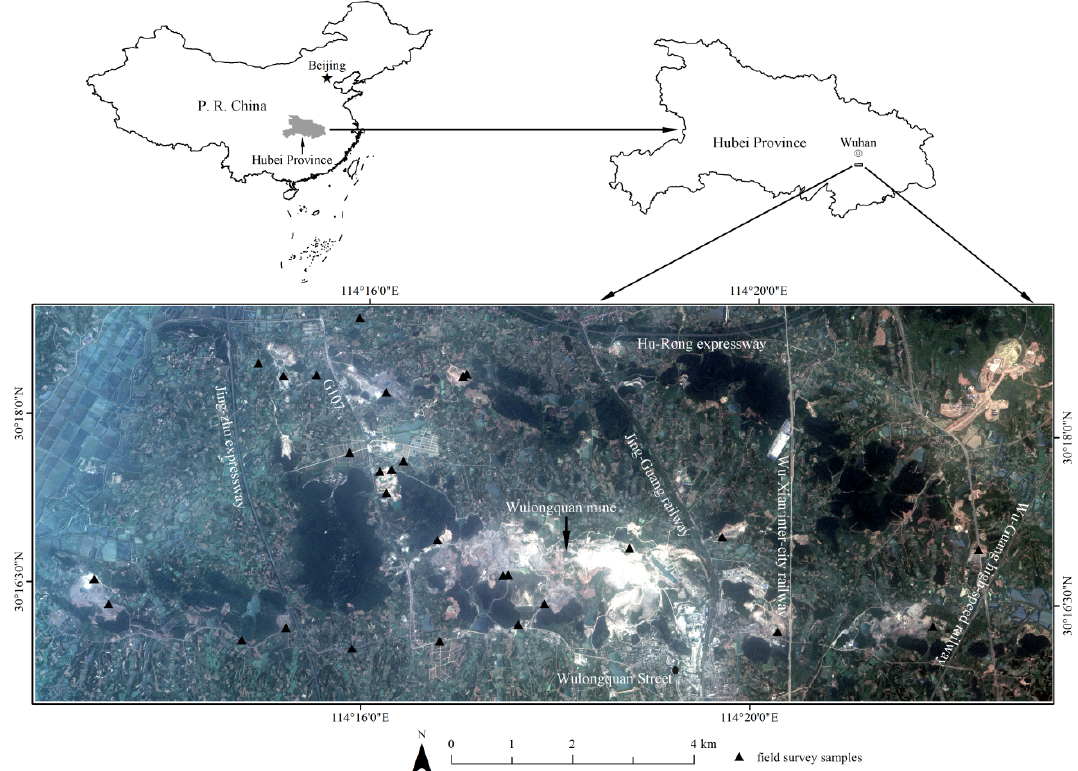
Figure 1. ZiYuan-3 fused imagery and location of the study area and field samples